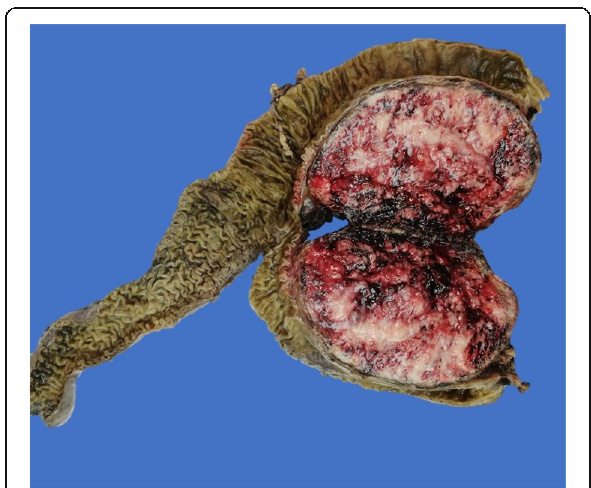
Fig. 1 Gross appearance of SPN. Well circumscribed mass in head of pancreas. Cut surface is partly solid with focal hemorrhagic and cystic